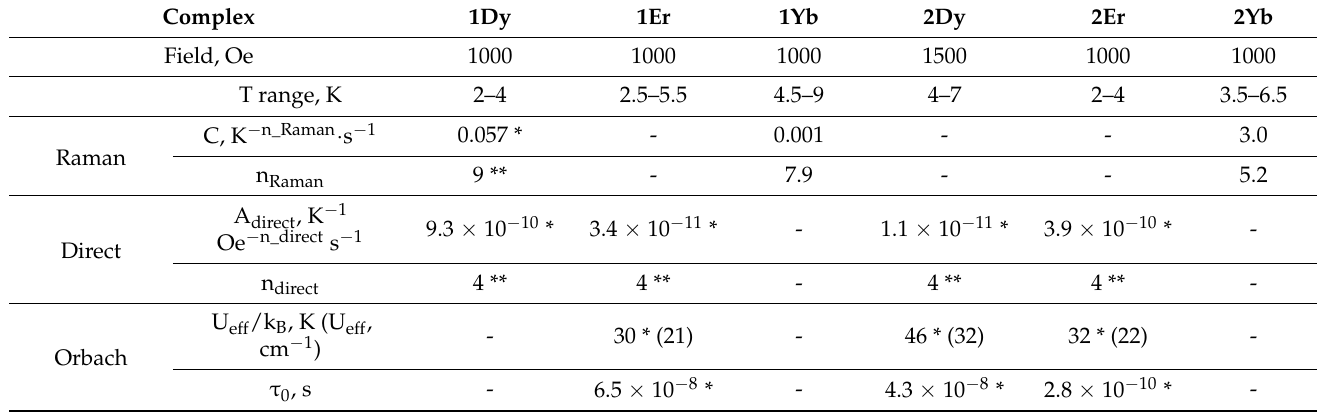
Table 2. Parameters of the most probable magnetic relaxation processes for the studied